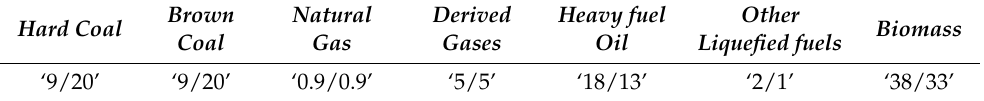
Table 2. Emission factors PM 2.5 /PM 10 for source category in energy industries (g/GJ). Brown Natural Derived Heavy fuel Other Hard Coal Biomass Coal Gas Gases Oil Liquefied fuels ‘9/20’ ‘9/20’ ‘0.9/0.9’ ‘5/5’ ‘18/13’ ‘2/1’